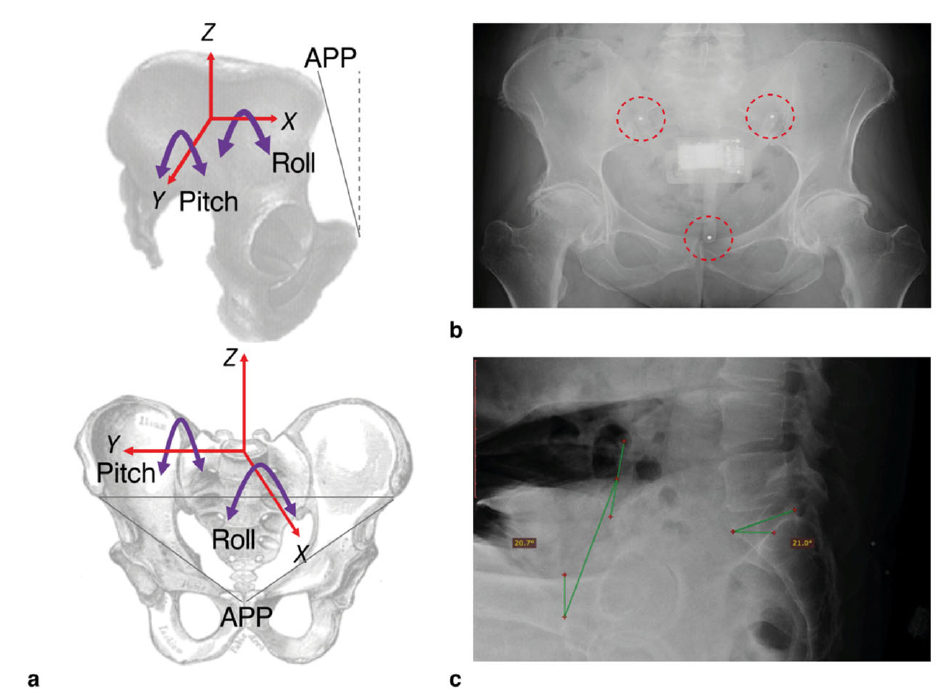
Figure 3. ( a ) The axes shown the image above demonstrate the measurements that can be taken from the IMU device. For this study, the only IMU measurement taken was pitch (i.e., tilt in the anterior- posterior direction, around the Y -axis). ( b ) The positioning of the device was checked by using 3 mm steel bearings inserted into the legs. The radiographic assessments were taken by measuring the angle of the anterior pelvic plane (defined as the plane between the anterior superior iliac spine and the pubic tubercle, relative to the vertical dashed line). ( c ) An example of this is shown.